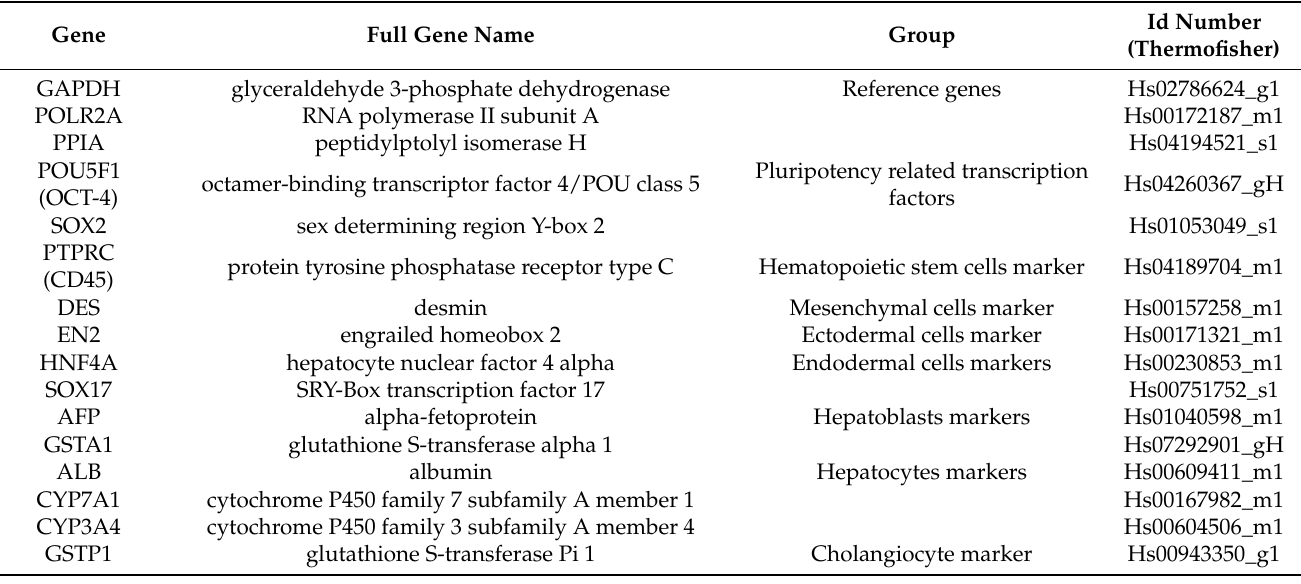
Table 2. List of tested